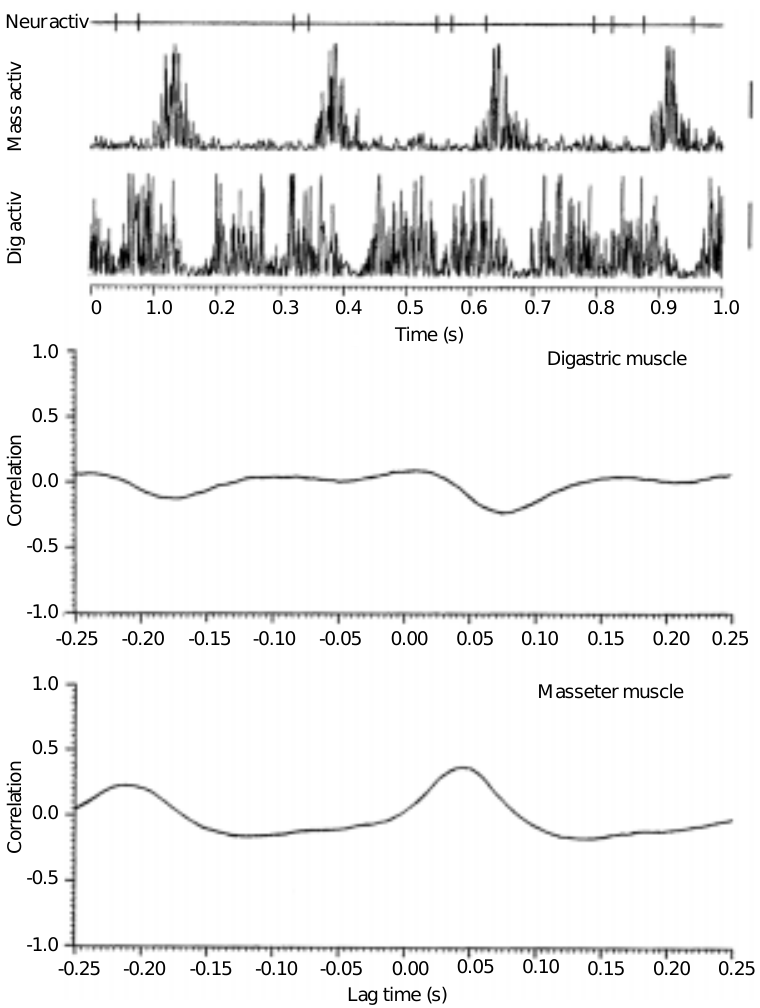
Figure 4. Activity of a non-serotonergic neuron located in the nucleus raphe obscurus and activity of the digastric and masseter muscles during 1 s of drinking behavior. Neur activ, neuronal activity; Mass activ, masseter electromyographic activity; Dig activ, digastric electromyographic activity. Vertical bars on the right represent 100 µV (upper panel). Cross- correlation between neuronal activity and digastric (middle panel) and masseter (bottom panel) muscle activities (1-ms bin width in each